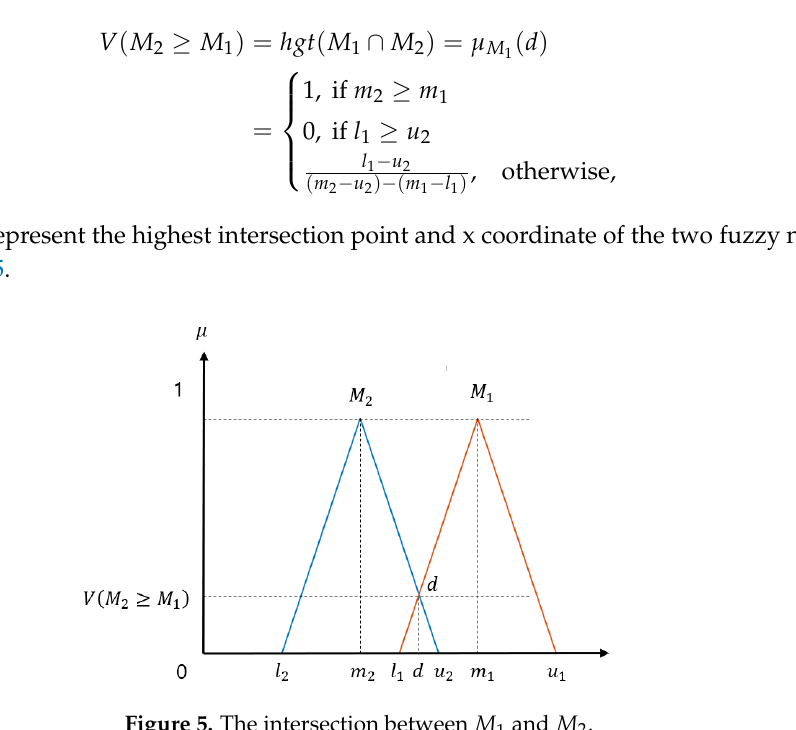
Figure 5. The intersection between M 1 and M 2